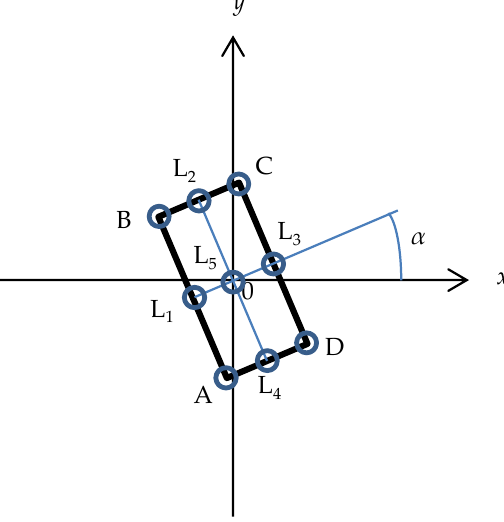
Figure 1. Definition of wind direction α and representative locations on the roof. Circles indicate the representative locations, which are corners A–D, midpoints of an edge L 1 –L 4 , and center L 5 . Table 1. List of run cases with various dimensions of the target building and wind directions. Here, H = 0.16 m.